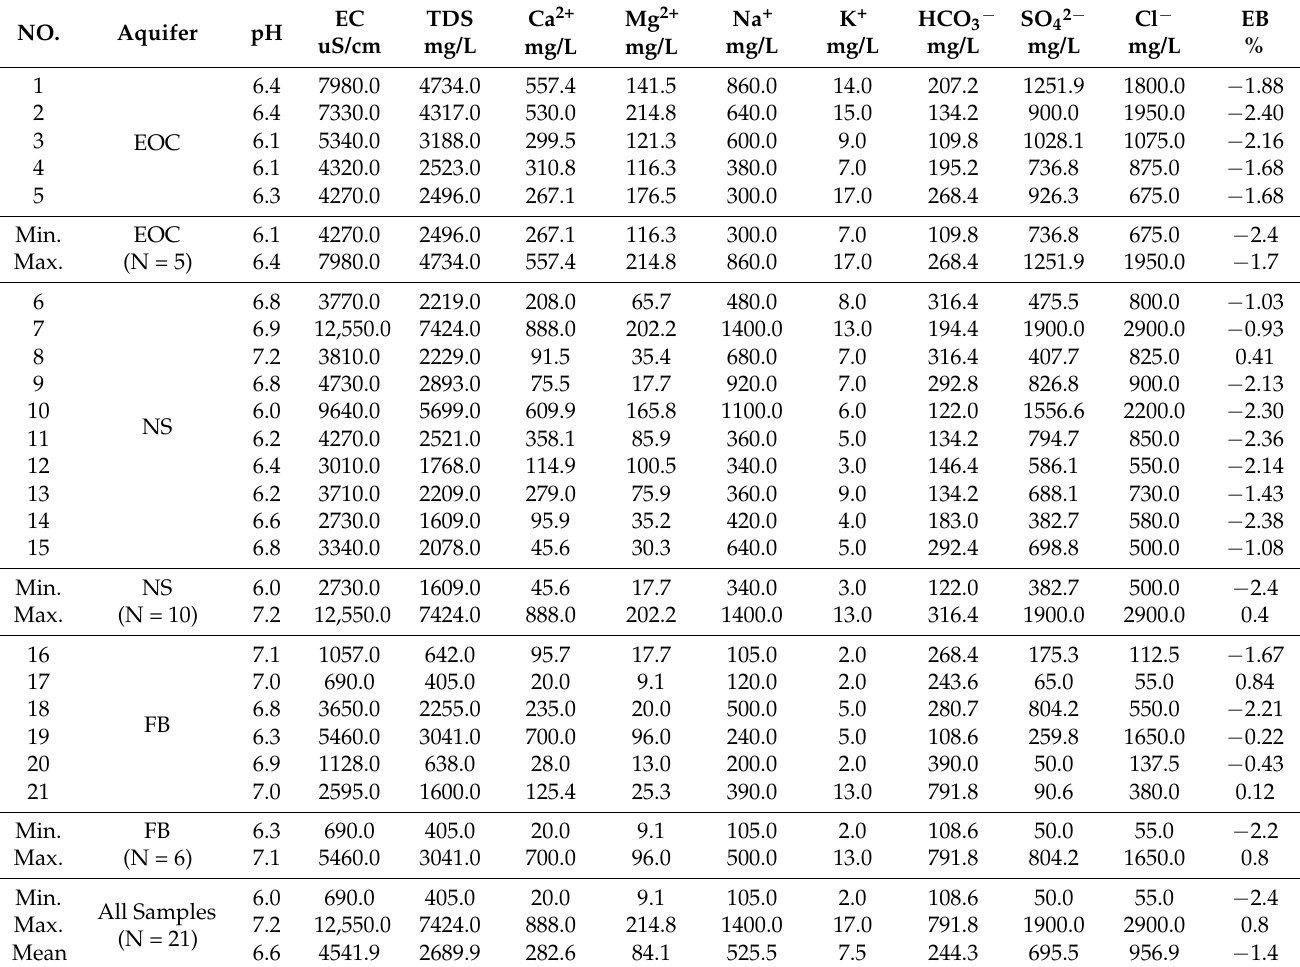
Table 1. Physicochemical parameters and major ions concentrations (mg/L) in EOC, NS, and FB